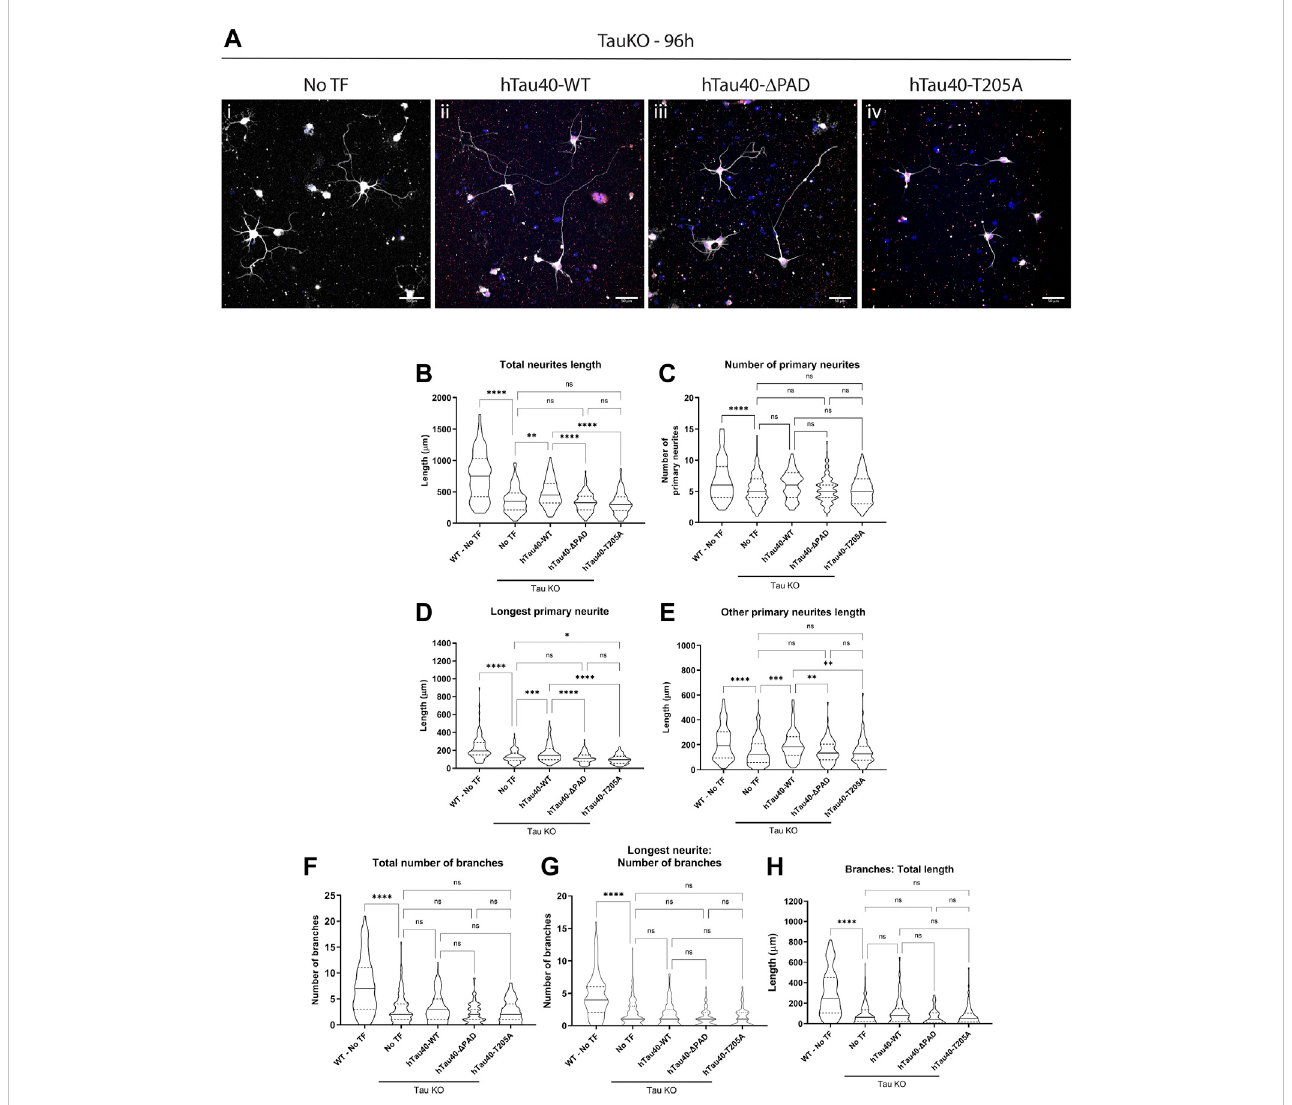
Transfection with hTau40-WT, but not with hTau40- Δ PAD and hTau40-T205A, improves neurite outgrowth of tau KO hippocampal neurons. Primary hippocampal neurons from tau KO mice cultured on poly- L -lysine + laminin were transfected 16 – 18 h after plating and cultured for a further 72 h before fi xationandstainingfor β 3-tubulin. (A) TauKOhippocampalneuronshavelimitedneuriteoutgrowthafter96 h1)butoutgrowthisimprovedaftertransfection with hTau40-WT 2). By contrast, transfection of Tau KO hippocampal neurons with hTau40- Δ PAD 3) or hTau40-T205A (iv) does not improve neurite outgrowth compared to untransfected tau KO hippocampal neurons. Blue: DAPI, White: β 3-tubulin. Scale bars: 50 μ m. (B) The total length of all neurites is increased by transfection of hTau40-WT ( p = 0.0014) but not hTau40- Δ PAD ( p = 0.963) or hTau40-T205A ( p = 0.81). (C) The number of primary neurites for tau KOneuronswas slightly increased by transfection of hTau40-WTbutdidnotreachsigni fi cance ( p = 0.1937). hTau40- Δ PAD ( p > 0.999) orhTau40-T205A ( p > 0.999)transfectiondidnotincreasethenumberofprimaryneurites. (D) Impairedaxonaloutgrowthwassigni fi cantlyimprovedbytransfectionofhTau40- WT ( p = 0.0005). By contrast, transfection of hTau40- Δ PAD did not increase axonal outgrowth ( p = 0.944). After transfection of hTau40-T205A tau KO actuallyshowedlessaxonal outgrowththanuntransfectedneurons( p =0.0242). (E) DendriticoutgrowthwasalsoincreasedbytransfectionwithhTau40-WT ( p = 0.0005). Transfection of hTau40- Δ PAD ( p > 0.999) or hTau40-T205A ( p > 0.999) did not increase dendritic outgrowth. (F) The total number of branches oftauKOhippocampalneuronstransfectedwithhTau40-WT( p > 0.999),hTau40- Δ PAD( p =0.424)orhTau40-T205A( p =0.986)wasnotincreased. (G) The number of axonal branches after transfection with hTau40-WT ( p > 0.999), hTau40- Δ PAD ( p = 0.093) or hTau40-T205A ( p = 0.430) was not increased. (H) ThetotallengthoftauKOneuronaxonalanddendriticbrancheswasnotincreasedbytransfectionwithhTau40-WT( p =0.999),hTau40- Δ PAD( p =0.698)or hTau40-T205A ( p = 0.698). All data was collected after 96 h in culture. N = 101 – 115 individual neurons analyzed (see Supplementary Tables S4, 5). **** p < 0.0001, *** p < 0.001, ** p < 0.01, * p <